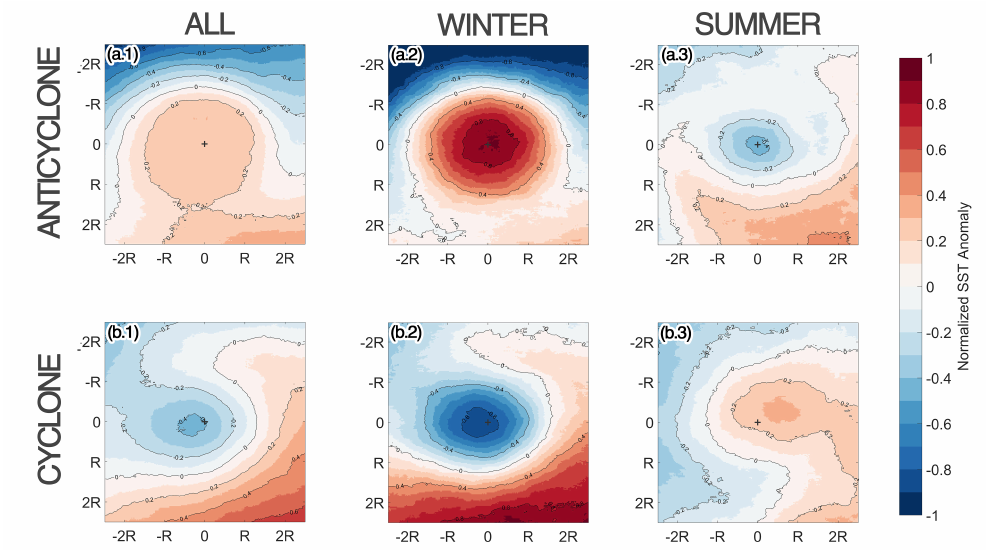
Figure 4. Composite averages of normalised SST anomaly for ( a ) Anticyclonic and ( b ) Cyclonic eddies for ( 1 ) all, ( 2 ) winter (DJF), and ( 3 ) summer (MJJ) observations. Each value in an eddy SST patch is normalised by subtracting the mean value and dividing by the standard deviation of all values. Composites are retained by averaging between